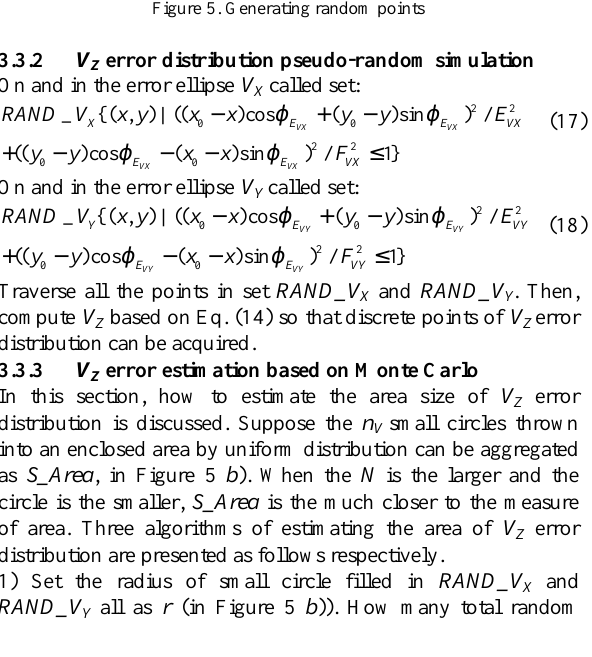
b ) Error ellipse filled with circles Figure 5. Generating random